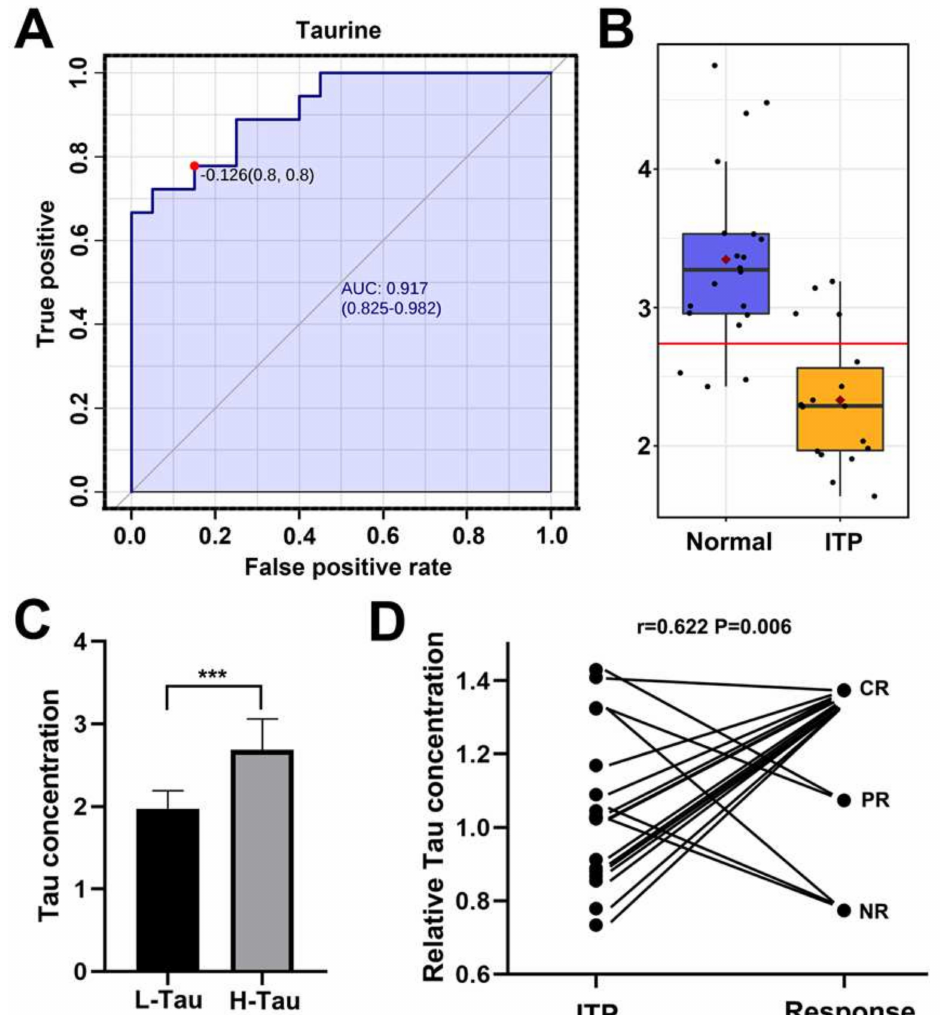
Figure 4. ( A ). The receiver operating characteristic (ROC) plot of taurine of spleen to distinguish immune thrombocytopenia (ITP) from the normal. ( B ). The box plot of taurine level between ITP and the normal. ( C ). The histogram of taurine level in spleen from low − taurine (L − Tau) and high − taurine (L − Tau) ITP patients ( n = 9, respectively). *** represents p -value of student’s t test lower than 0.001. ( D ). The correlation plot between response of ITP patient to splenectomy and taurine concentration in spleen. Each black dots represent a sample. Correlation coefficient r and corresponding p -value were derived from Spearman correlation analysis; NR: no response; PR: partial response; CR: complete